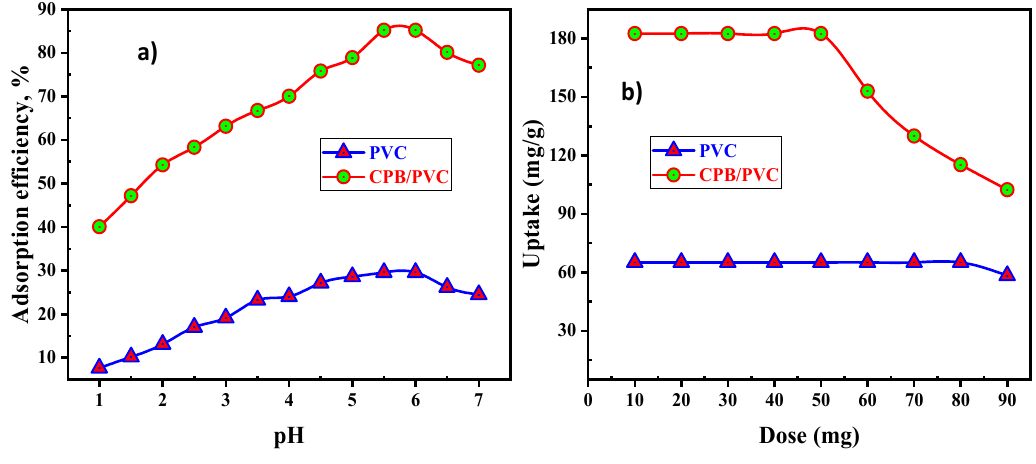
Figure 6. Effect of ( a ) pH and ( b ) sorbent dose on the REE sorption.